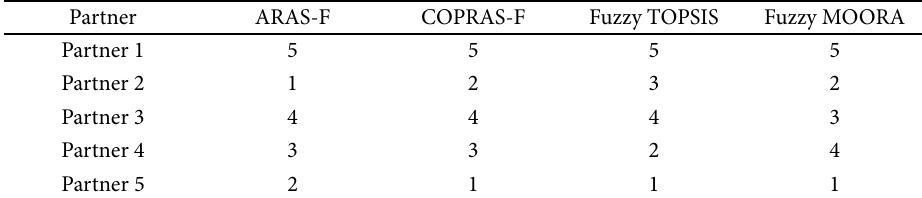
Table 18. The ranking of alternatives with four methods Partner ARAS-F COPRAS-F Fuzzy TOPSIS Fuzzy MOORA Partner 1 5 Partner